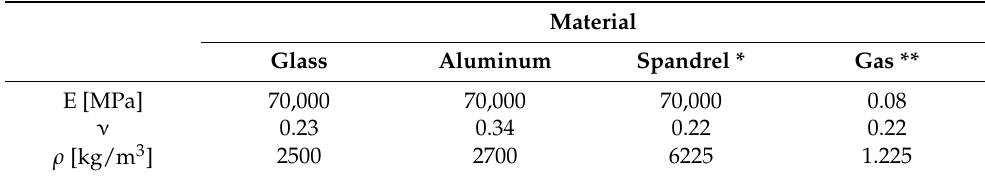
Table 4. Input mechanical properties for the materials in